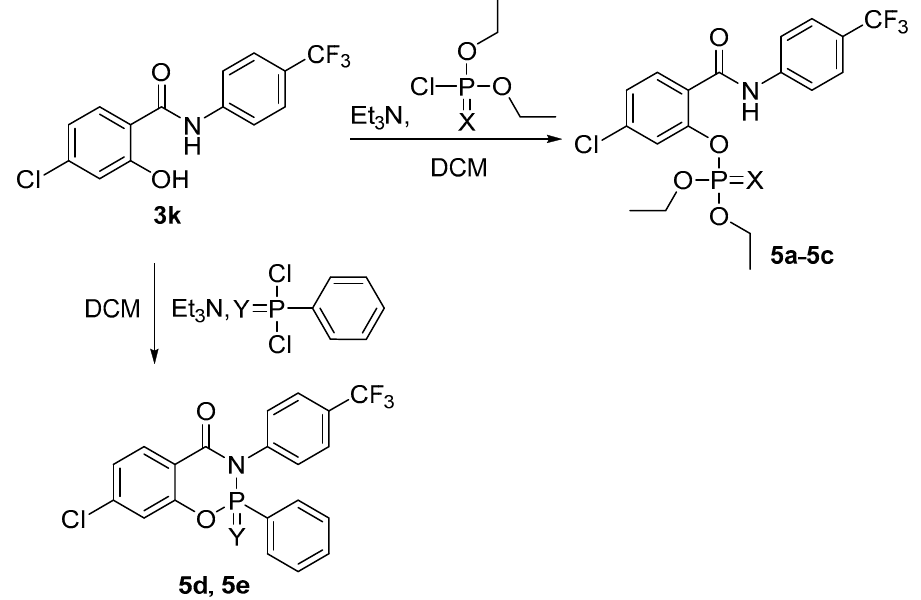
Table 1. Structures of 2-hydroxybenzamides and IC 50 for acetylcholinesterase and butyrylcholinesterase.